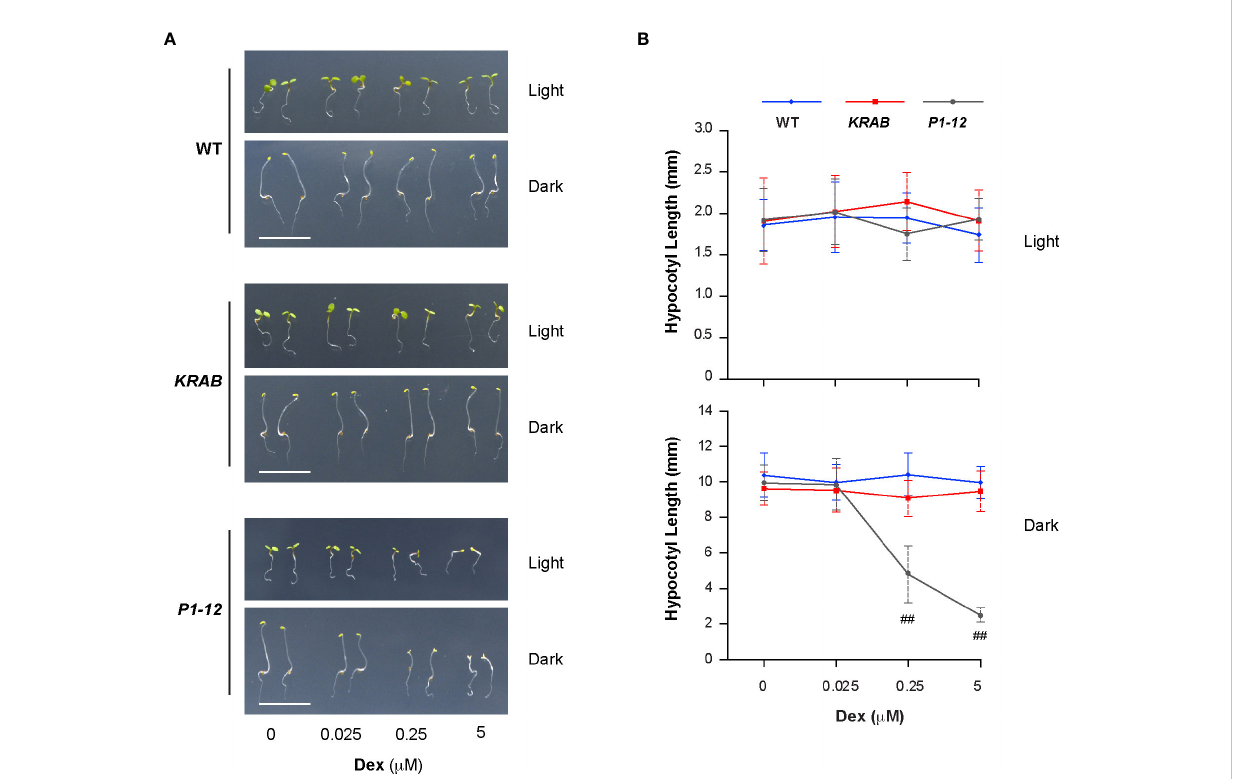
FIGURE 5 Reduction of MORF2 in P1-12 upon Dex treatment inhibits skotomorphogenesis. (A) Representative seedlings grown for 3 d under LD or in dark on media containing different concentrations of Dex. Bar = 1 cm. (B) Effect of different concentrations of Dex on hypocotyl elongation. Seedlings were grown for 3 d as in (A) before measurement. Double hash tags identify points with signi fi cant reductions of hypocotyl length in P1-12 than those in WT and KRAB (Student ’ s t test; P < 0.01). Each data point represents mean (± SD) of 20